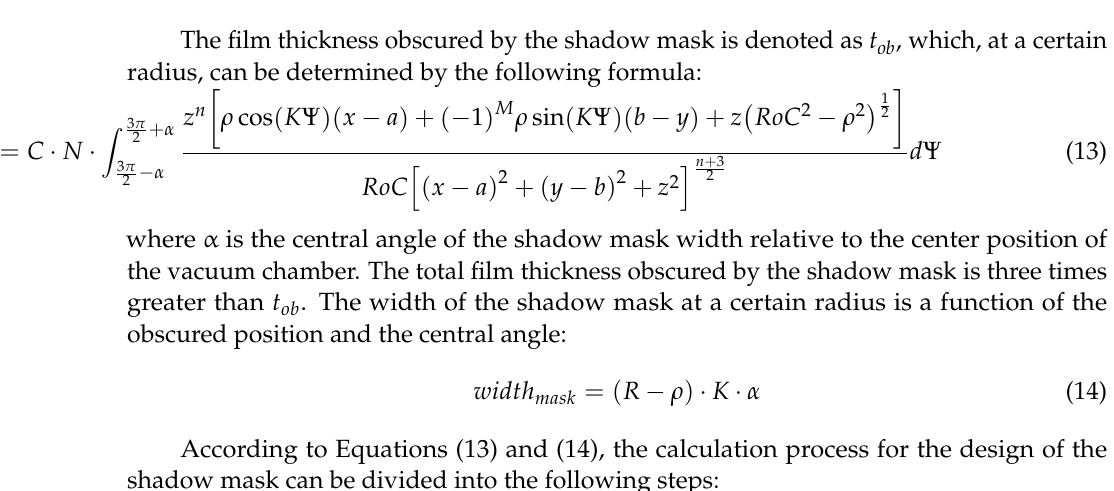
Figure 13. Paths described by a point at ρ = 350 mm for a system with a 217/37 gear ratio undergoing a single revolution and intersecting the shadow mask three times.